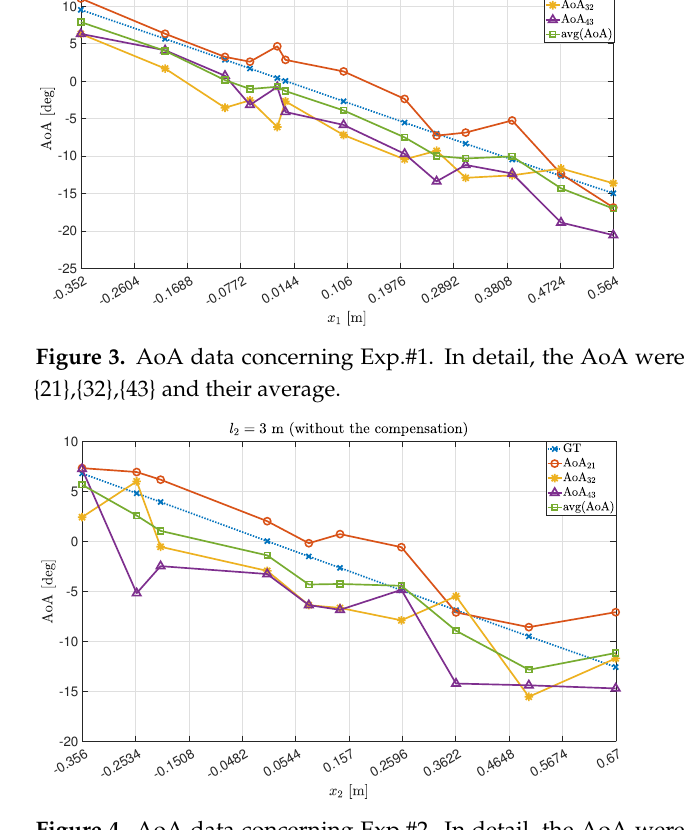
Figure 4. AoA data concerning Exp.#2. In detail, the AoA were computed thanks to the couples {21},{32},{43} and their average. The obtained values were compared to the theoretical ones (the Ground Truth angles,